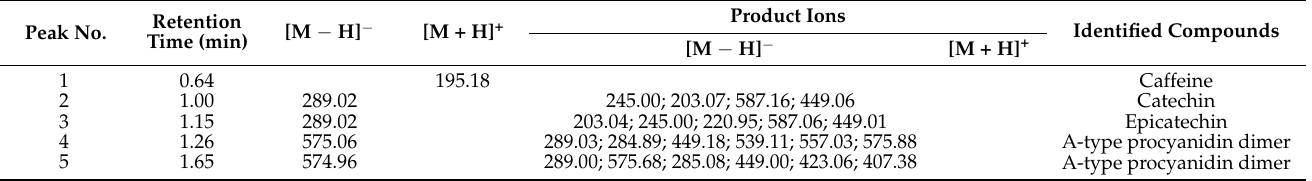
Table 1. Compounds tentatively identified in the guarana seeds extract by UPLC-PDA-MS analyses. Peak